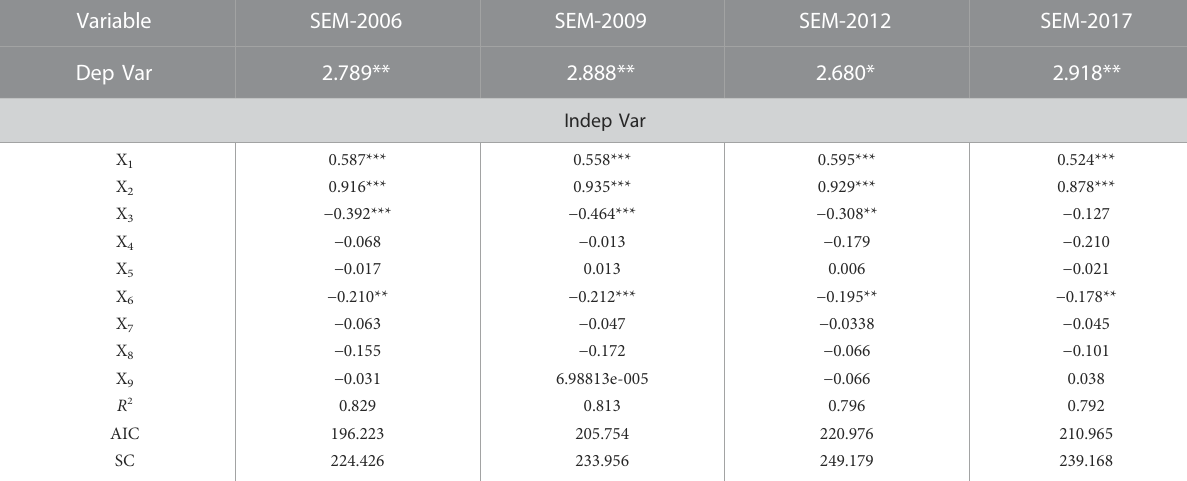
TABLE 6 Spatial regression results of GDP of the 13 province ’ s in North China (2006, 2009, 2012, and 2017).